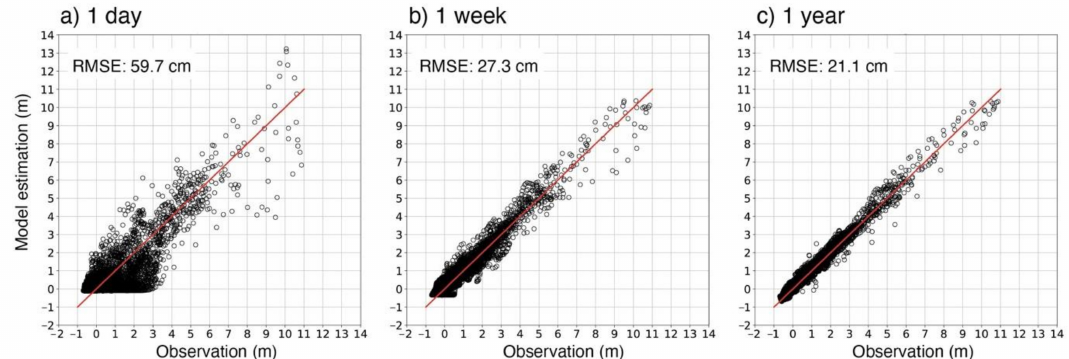
Figure 11. Scatter plots between stage observation and estimate for the test dataset for models using three lengths of the precipitation time series. ( a ) With a one-day time series. ( b ) With a one-week time series. ( c ) With a one-year time series. Red solid lines give the 1:1 relation. RMSEs are shown in the